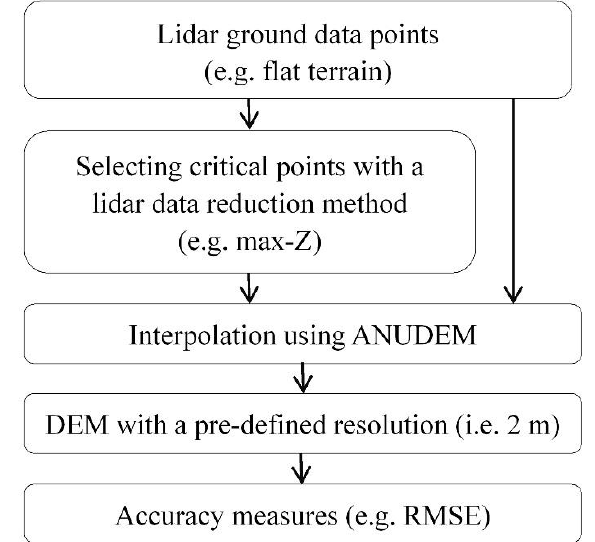
Figure 6. Flow chart of the scheme used to assess the accuracy of data reduction